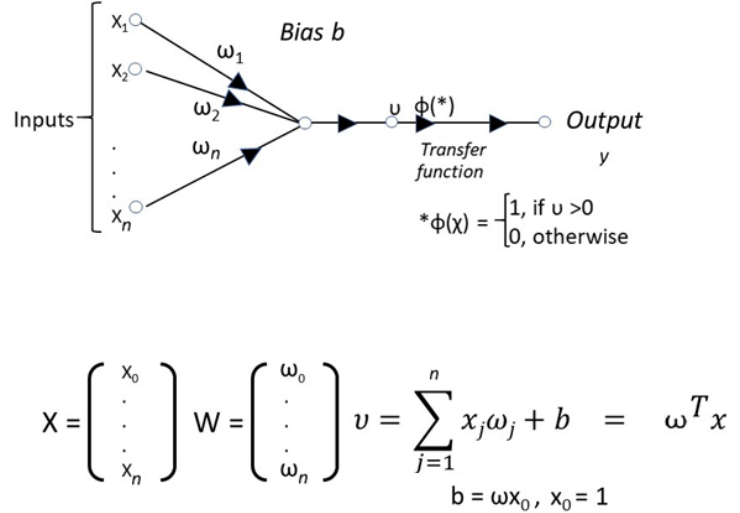
Figure 3. The multilayer perceptron (MLP) feedforward classifier structure with vector inputs represented as x 1 , x 2 , … , x n , weights as ω 1 , ω 2 , … , ω n ; b is the bias and φ is the transfer function; υ refers to the weighted sum of the input.